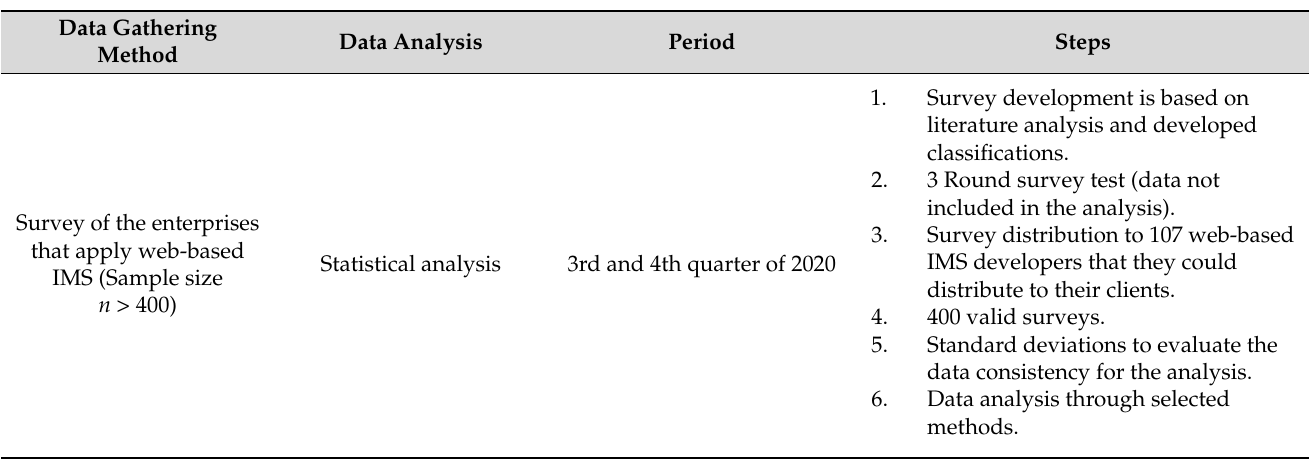
Table 3. Data collection and analysis